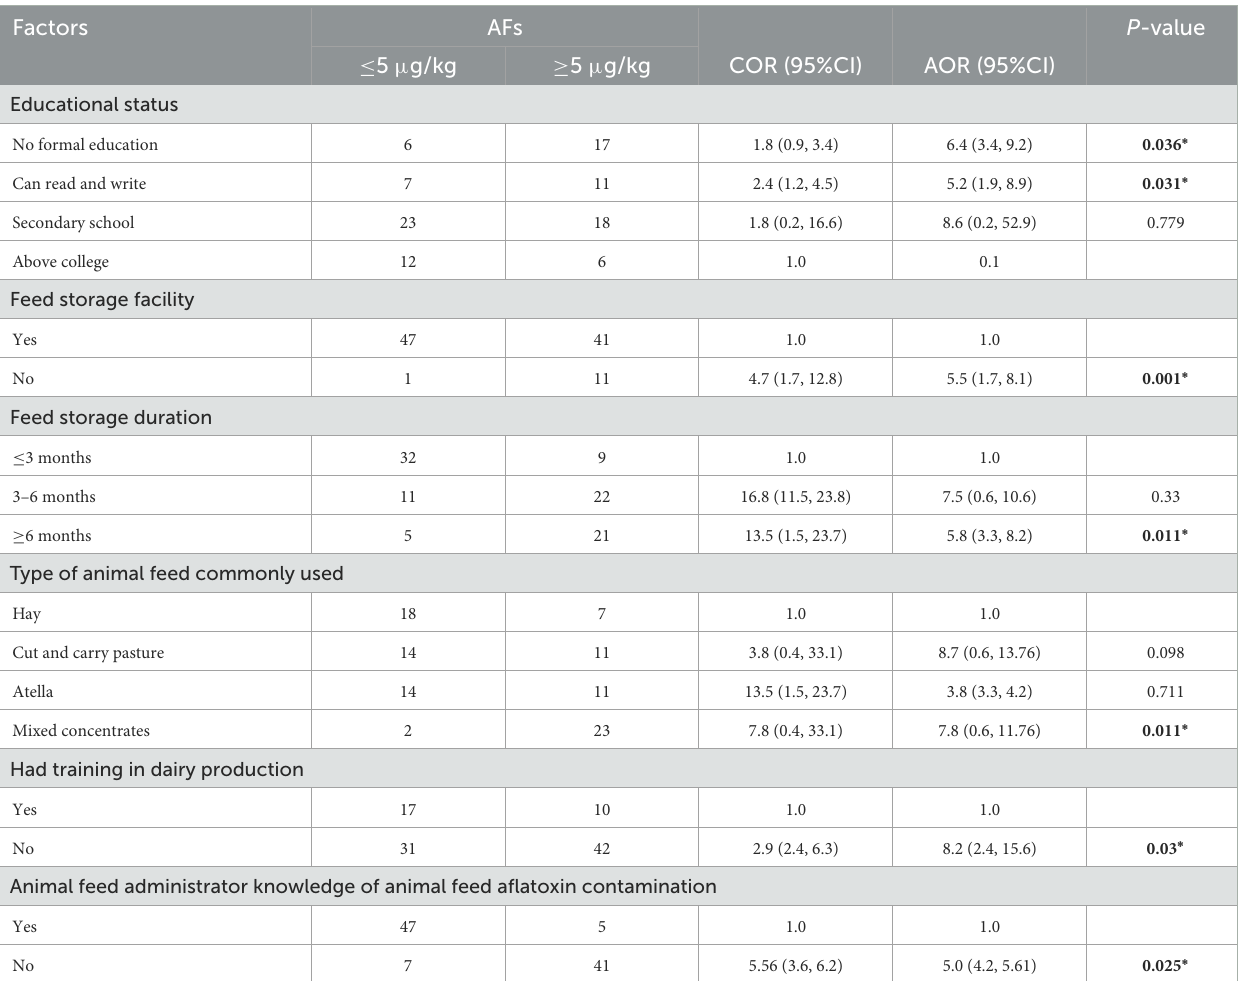
TABLE 3 Logistic regression analysis of factors associated with AF levels in animal feed ingredients ≥ 5 µ g/kg among dairy farms in SGZ, Northwest Ethiopia, 2021 ( n =